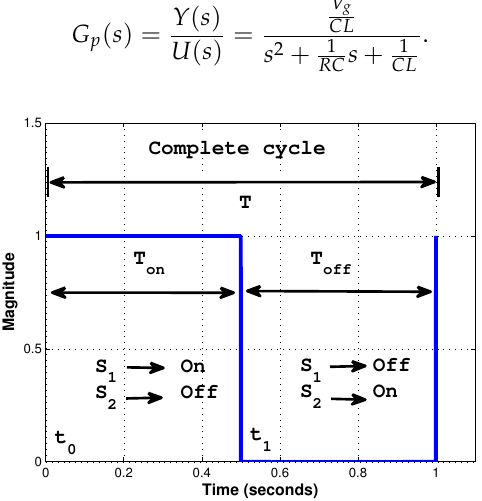
Figure 2. Duty cycle for the Buck converter on Figure 1, producing the described operating modes.